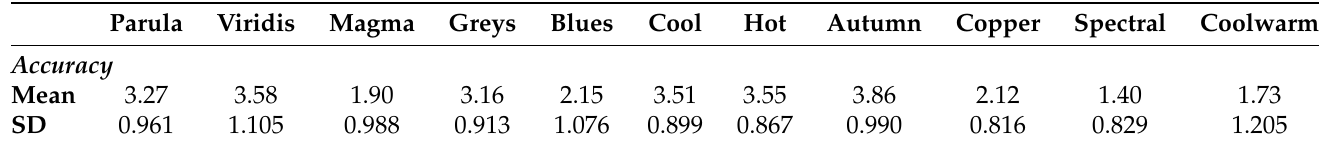
Table 3. Summary of the mean values and standard deviations of the colormap accuracy rated in crowdsourced study Part II with 99.5% CI.